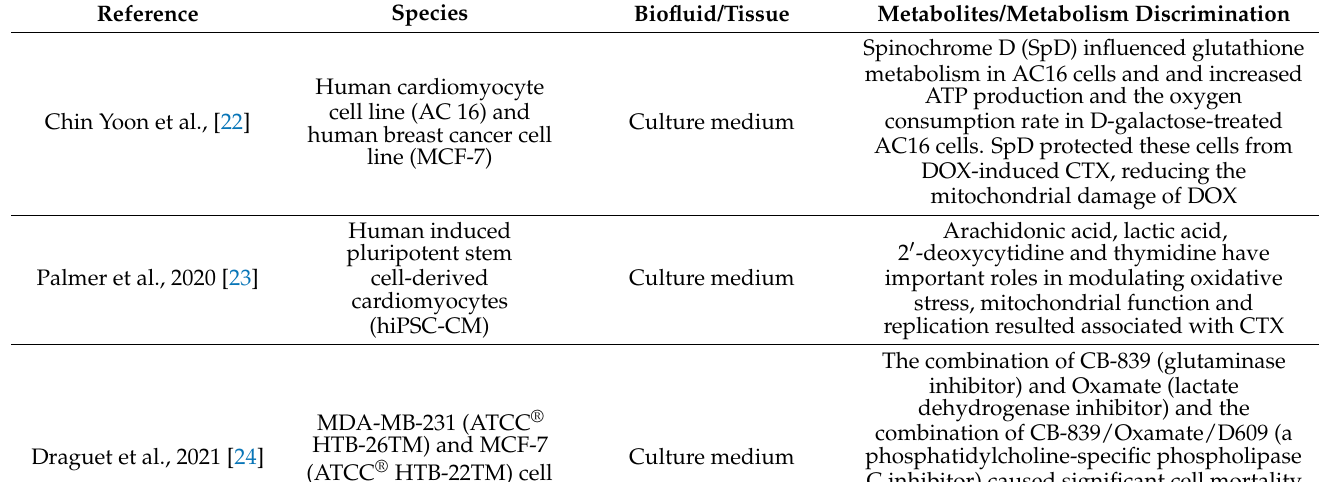
Table 2. Summary of techniques and results for early detection of drug-induced cardiotoxicity in human